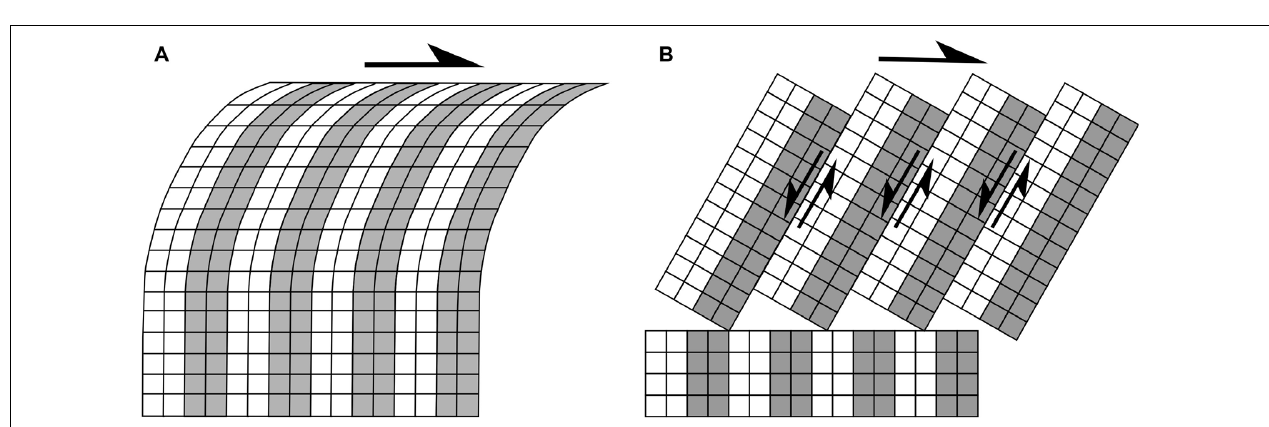
FIGURE 11 | (A) Sketch of dragging of the about N-S structures located south of the Grimsey Lineament right-lateral shear zone by heterogeneous simple shear with a smoothly increasing strain gradient. (B) Sketch of rigid clockwise block rotation (book-shelf type) that also may occur in correspondence of a right-lateral shear zone (after Nelson and Jones, 1987). Model B is not reconciled with field data collected in the northern part of the study